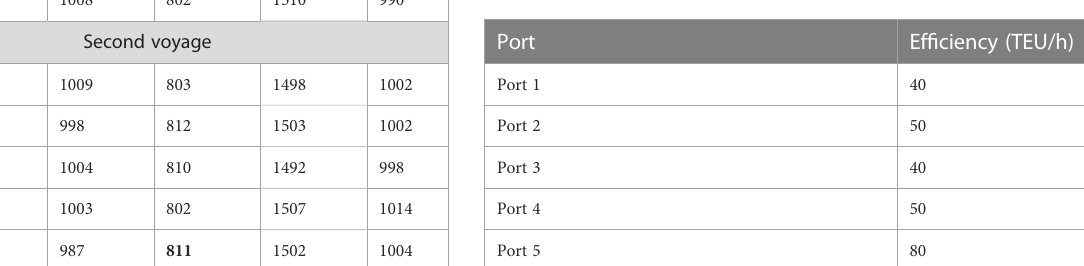
TABLE 3 Estimated port handling ef fi